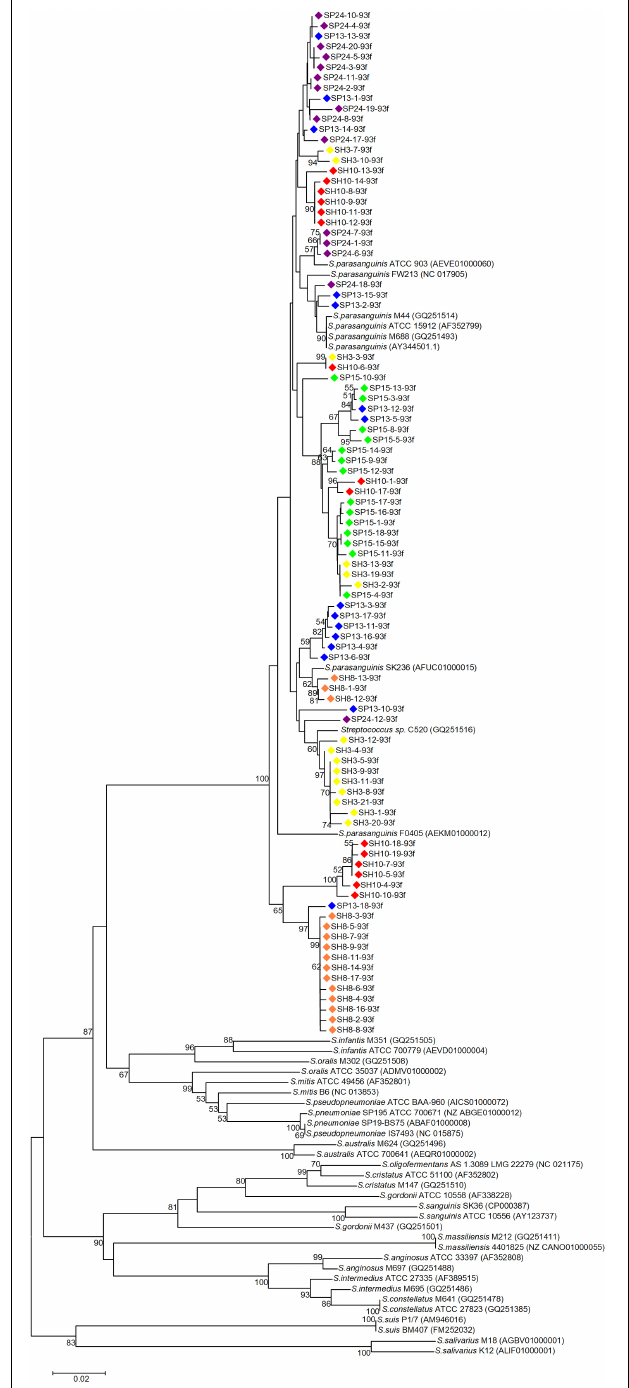
FIGURE 2 | Phylogenetic tree of the groEL gene fragments cloned by the primer pair Spa93f-Spa525r from the saliva of six human subjects and those of known Streptococcus species. The cloned sequences of the present study are labeled by dots of varied colors, and clones of the identical color are from the saliva sample of one person. Strains of known Streptococcus species retrieved from the GenBank are indicated by italics, and the accession numbers of their groEL genes are given in parentheses following the bacterial names. Bootstrap values greater than 50% are indicated at the